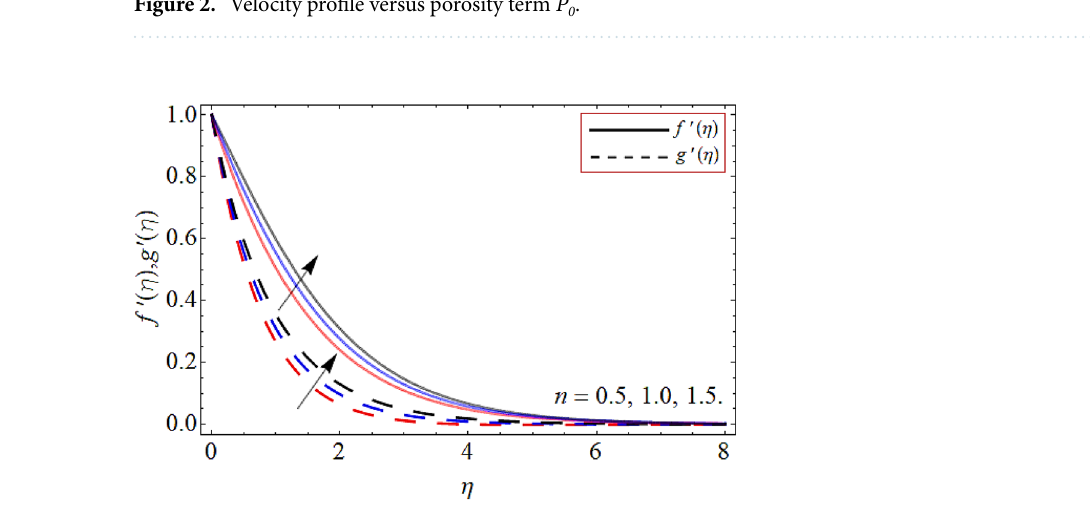
Figure 2. Velocity profile versus porosity term P 0 .